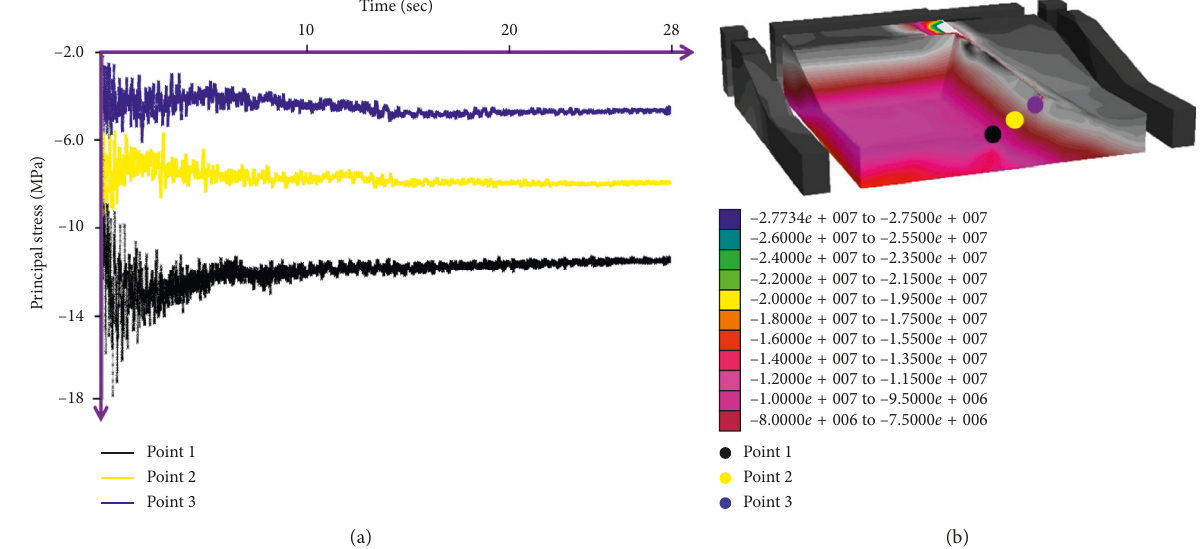
Figure 20: (a) Principal stress-time graphic for the Kocaeli earthquake. (b) Contour plot diagram for 28 th second of the Kocaeli earthquake.